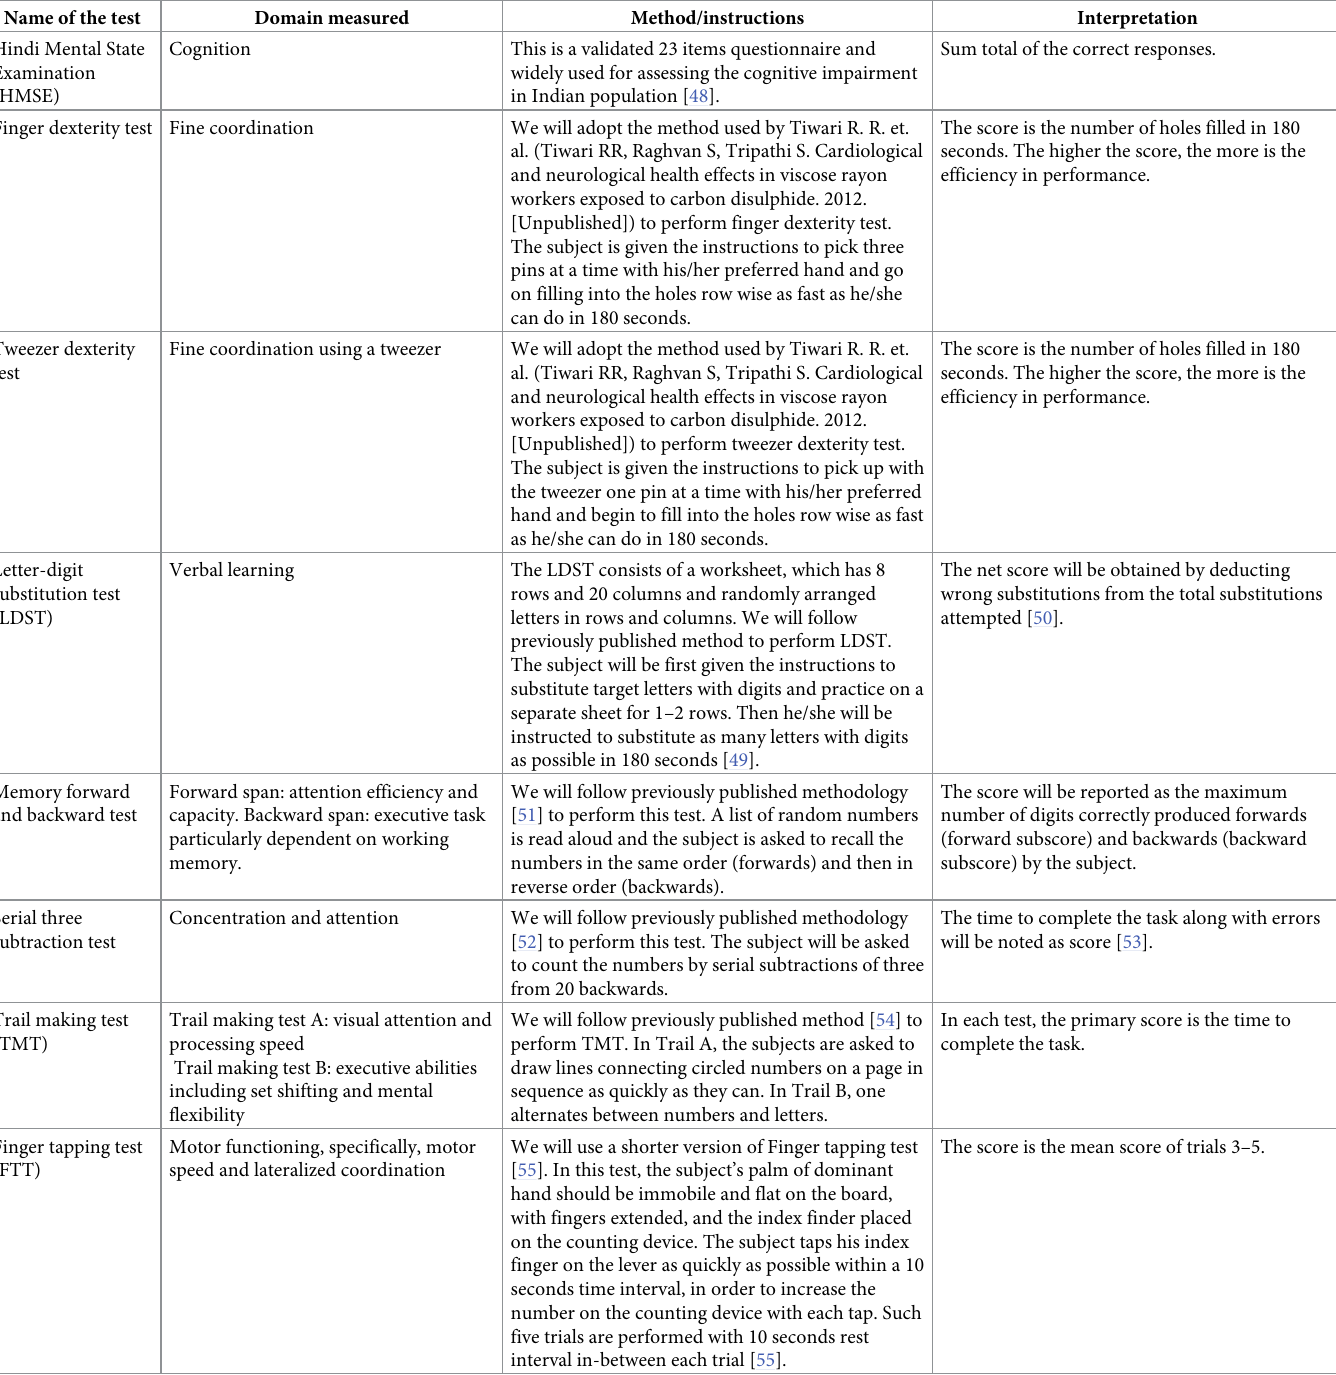
Table 2. Details of neurobehavioral tests to be administered to study